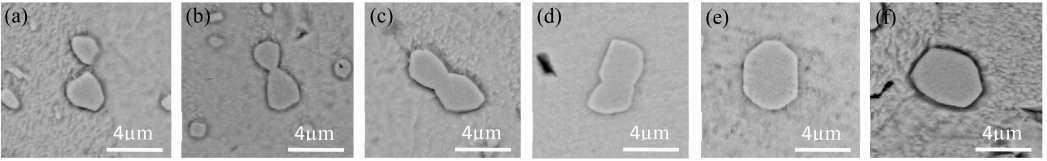
Figure 7. A schematic diagram of the Ag 3 Sn coarsening following the necking-coalescence during TS cycling.